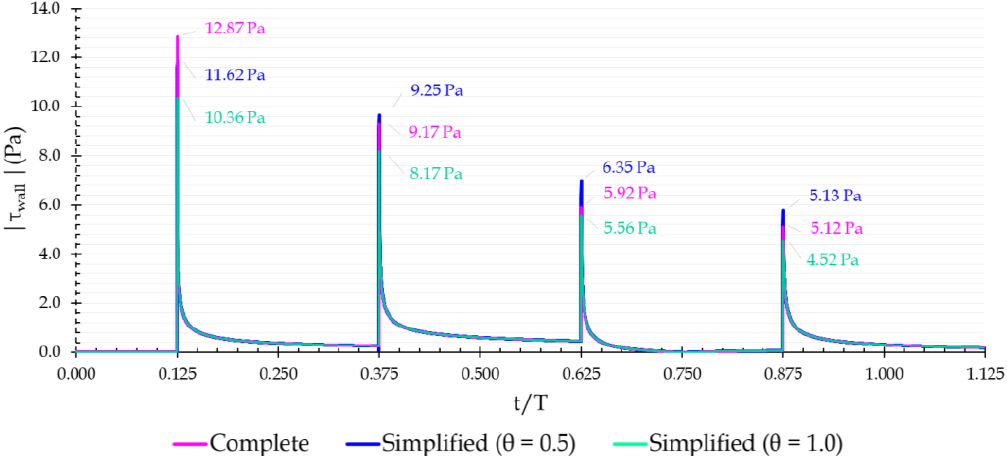
Figure 17. Wall shear stress simulation at pipe midsection for N C = 100. 0.0 ≤ t/T ≤ 1.25.